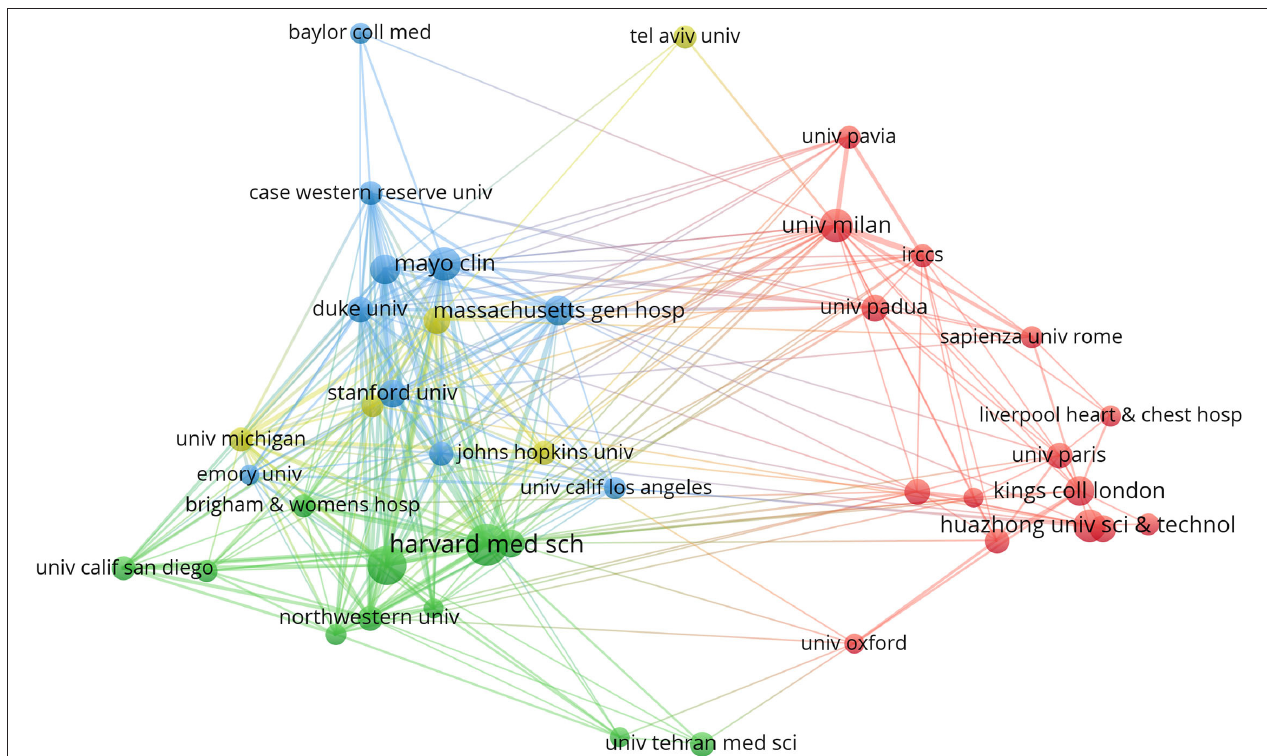
FIGURE 4 | Detailed information of organization distribution. The size of the circle represented its number of publications. Harvard Medical School had published the highest number of research publications in this field followed by the Columbia University and Mayo Clinic. Various institutions cooperated with each other, however, mutual exchanges and cooperation were relatively limited. Harvard Medical School, Columbia University, and Stanford University cooperated with each other most frequently. Huazhong University of Science and Technology, King’s College London, and Wuhan University cooperated more frequently.